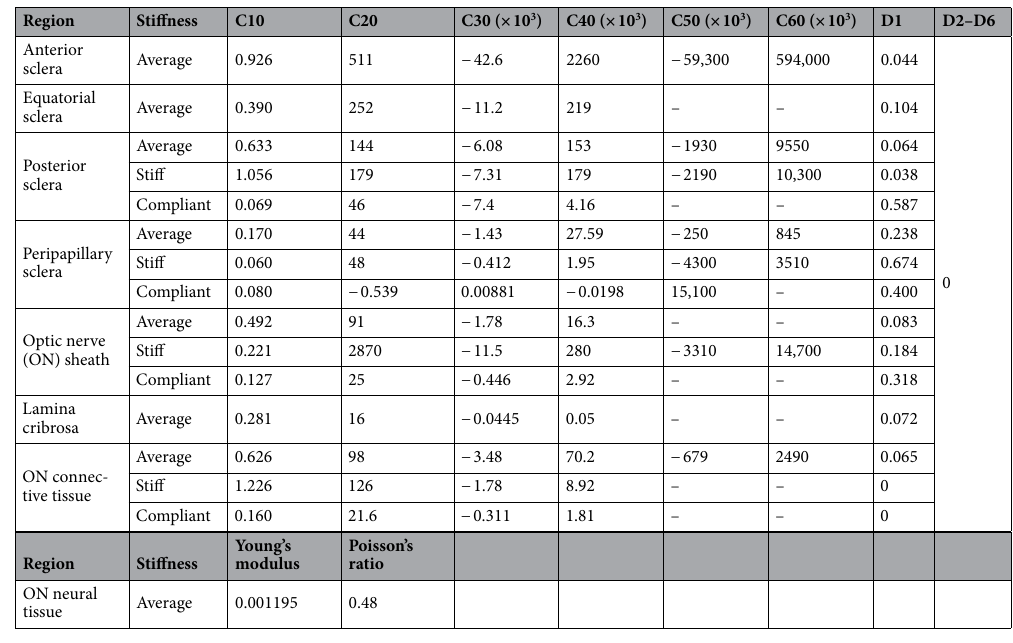
Table 1. Hyper-elasticity: reduced polynomial model and linear elasticity